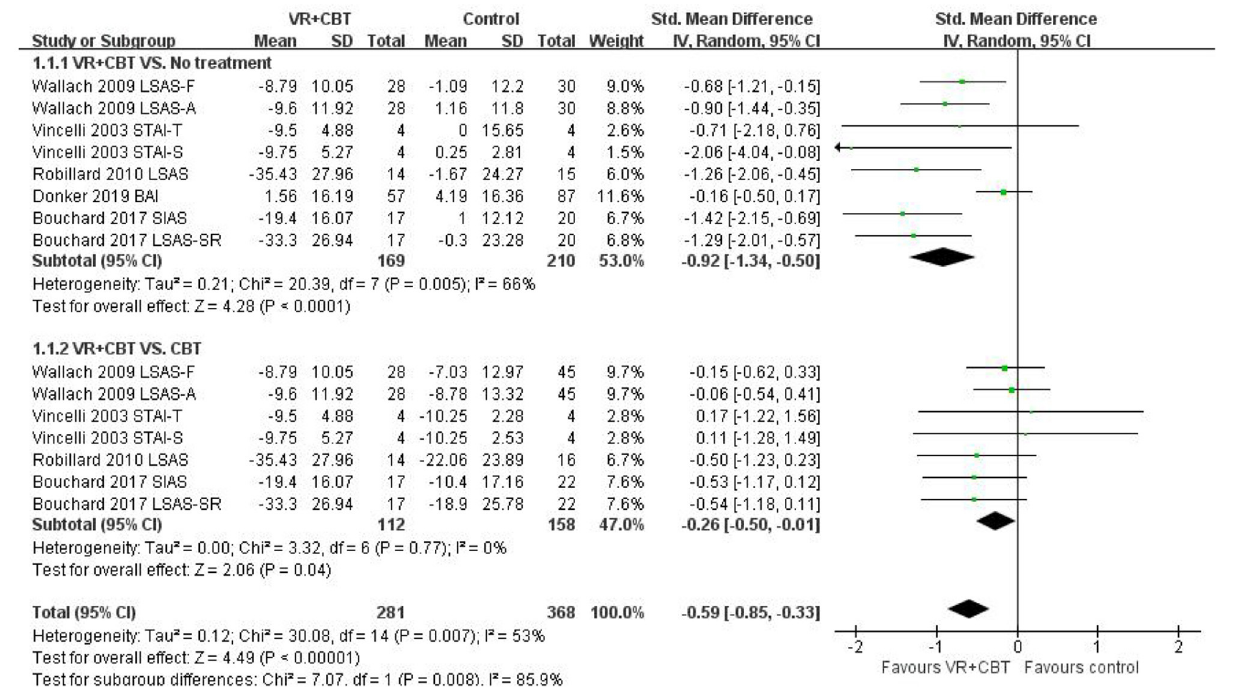
FIGURE 3 | Forest plot of VRCBT vs. no treatment or CBT comparators for anxiety severity.